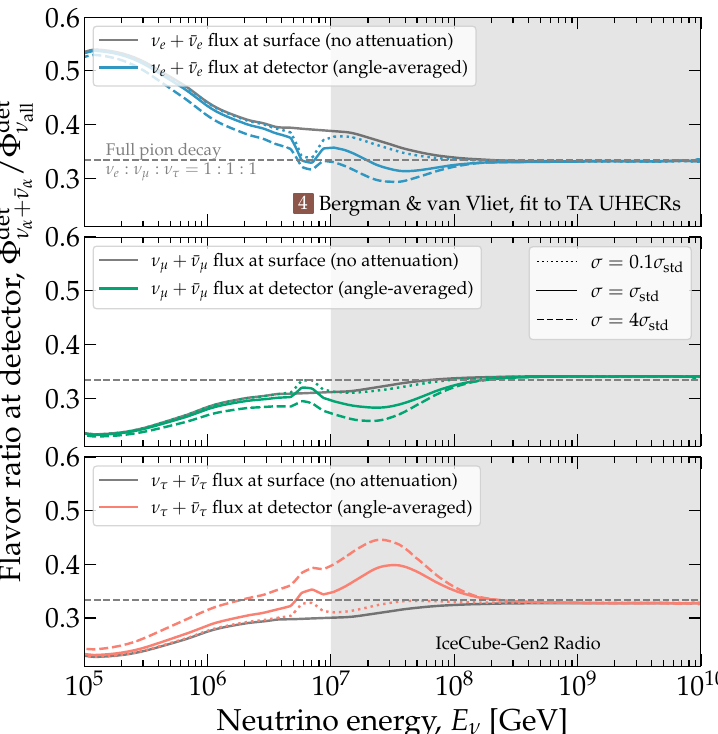
Figure 11 . Flavor ratios of neutrinos, i.e., ratios of the ν α + ¯ ν α flux compared to the all-flavor flux, at the surface of the Earth and at IceCube-Gen2, for the benchmark UHE flux model 4 [61] (see section 4). In this plot, the flavor ratios at IceCube-Gen2 are the average for Earth-skimming neutrinos with θ [85 ◦ , 95 ◦ ] . Like in figure 10, we show flavor ratios of fluxes propagated using the z ∈ central value of the BGR18 νN DIS cross section ( σ ) [63], and scaled-up and scaled-down versions std of it. For comparison, we show the nominal expectation of flavor equipartition at the surface of the Earth from neutrino production via the full pion decay